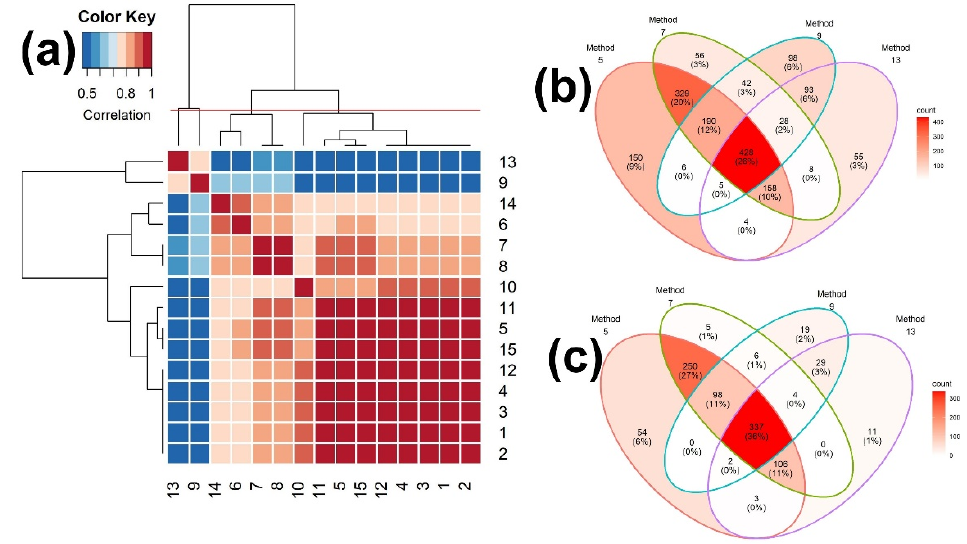
Figure 6. ( a ) Heatmap of the correlation matrix of identification among all 15 binary similarity measures for Rank 1 and ( b , c ) Venn diagrams of consensus analysis among 4 selected binary similarity measures for ESI mass spectra-based compound identification. In ( a ), the correlation was calculated using Pearson’s correlation coefficients. The horizontal red solid line indicates the four clusters generated by hierarchical clustering. The numbers in row and column represent the indices of binary similarity measures corresponding to Table 4 of Section 4; In ( b ), the Venn diagram was constructed based on all reference compounds with the highest corresponding similarity scores; In ( c ), the Venn diagram was constructed based on all reference compounds that were corrected identified.